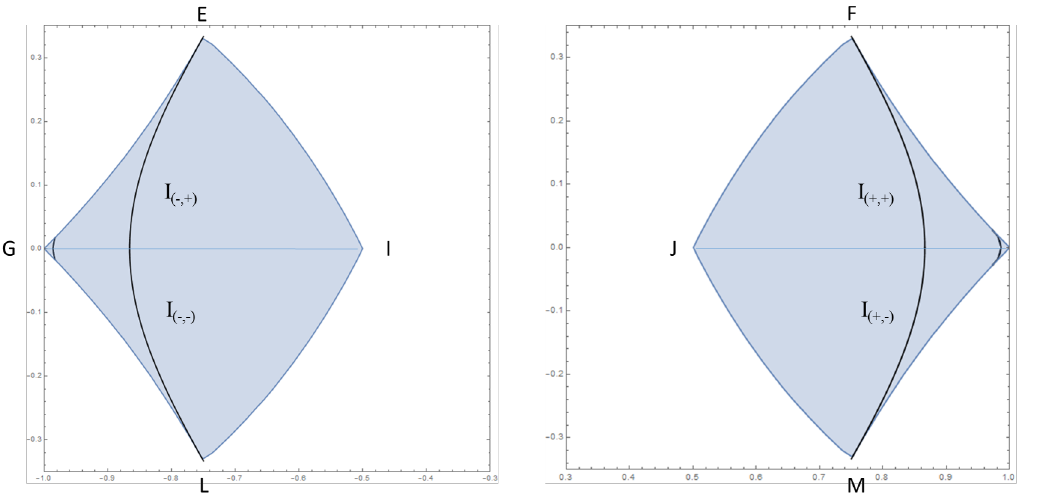
Figure 3. The region Ω with the isentropes represented as black curves: for h t = log2, the two largest curves connecting the points L , E and M , F , and for h t = log points G and K